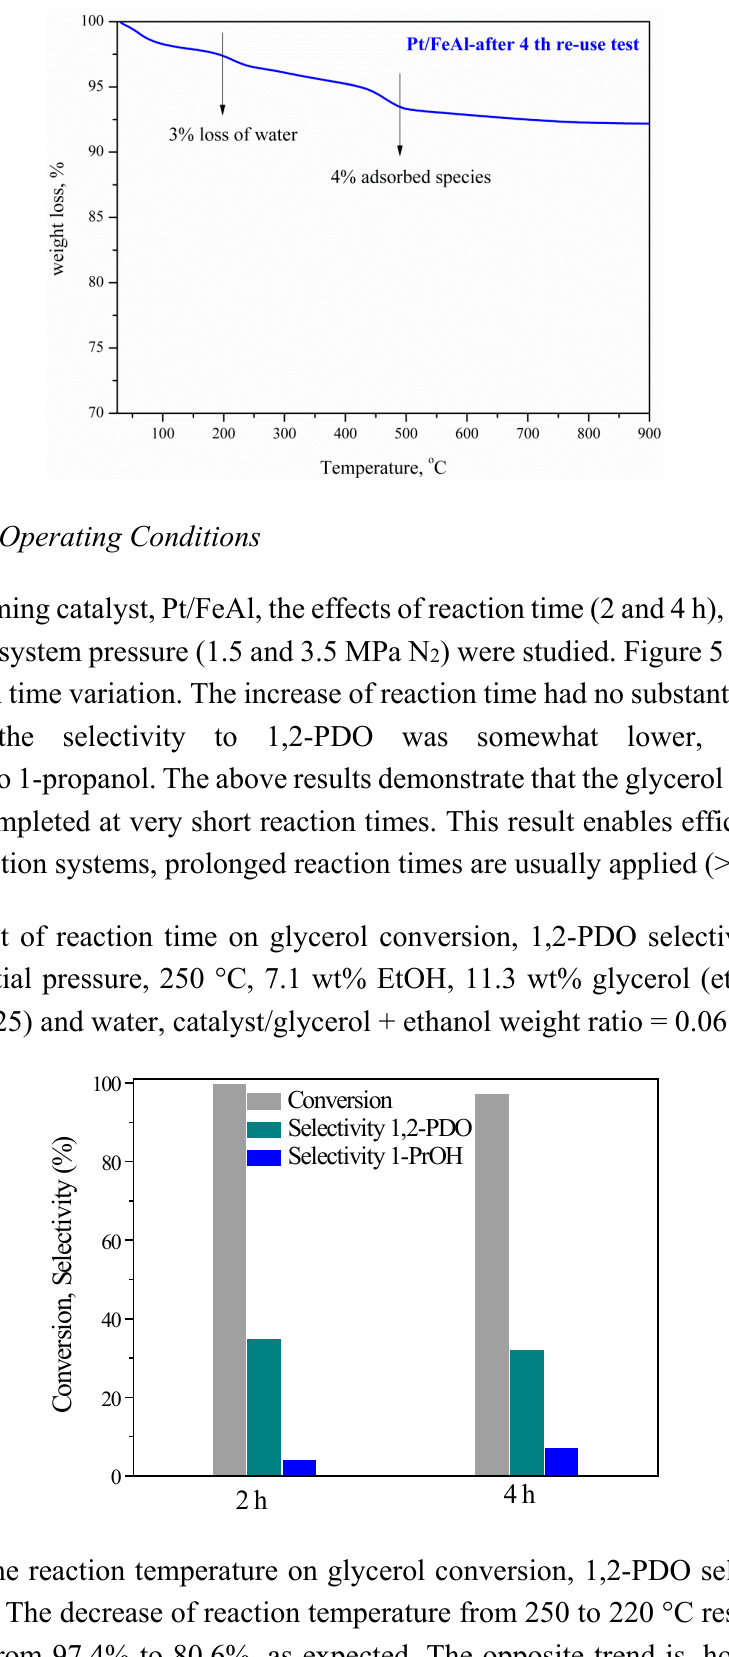
Figure 4. Thermogravimetric analysis in oxidative atmosphere of the fourth use of Pt/FeAl catalyst.